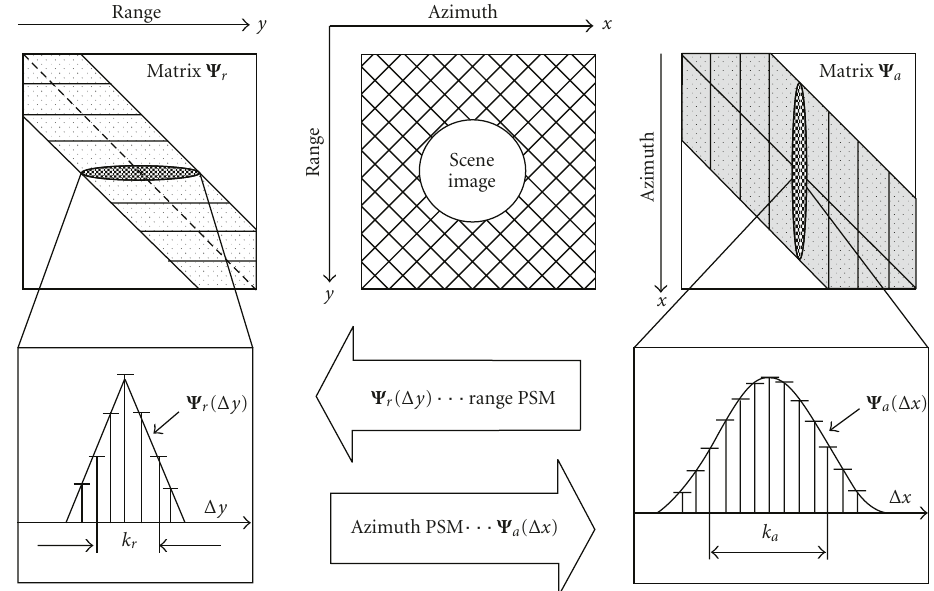
Figure 1: Illustration of the scene image degradations over the range and azimuth directions with factorized PSMs.